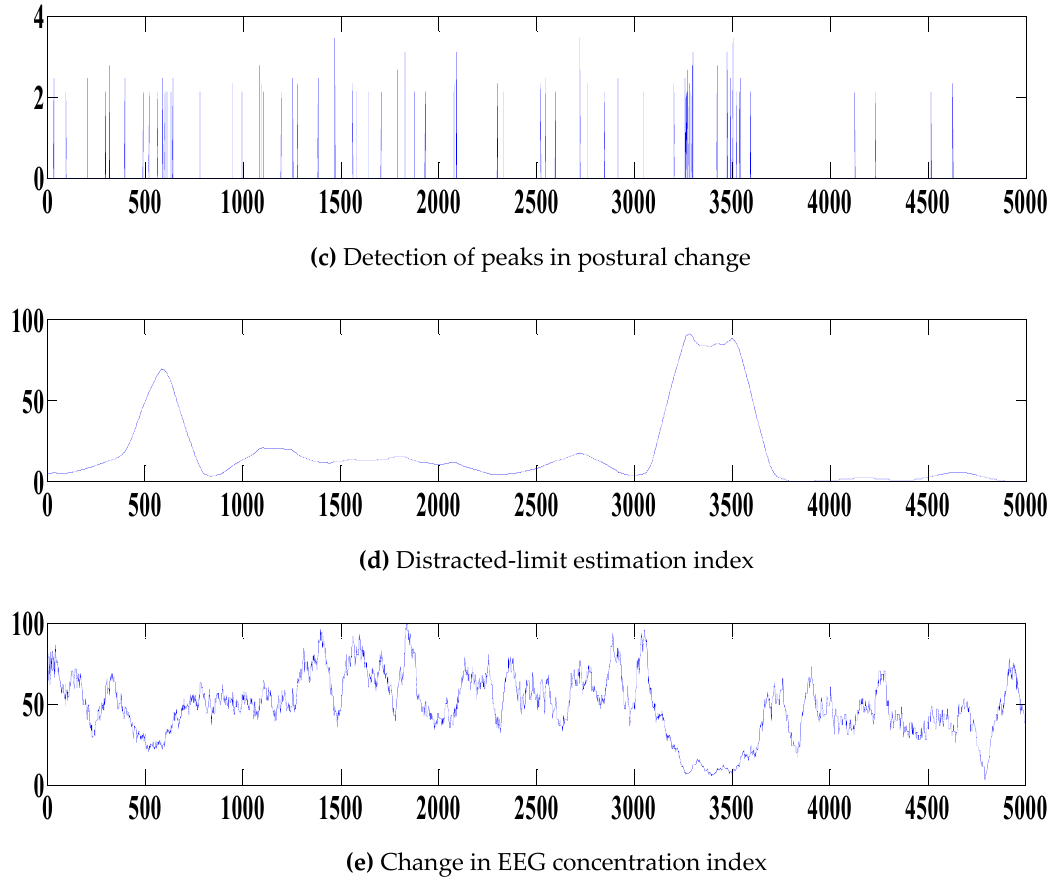
Figure 9. Detected amount of postural changes and peaks during the performance evaluation.